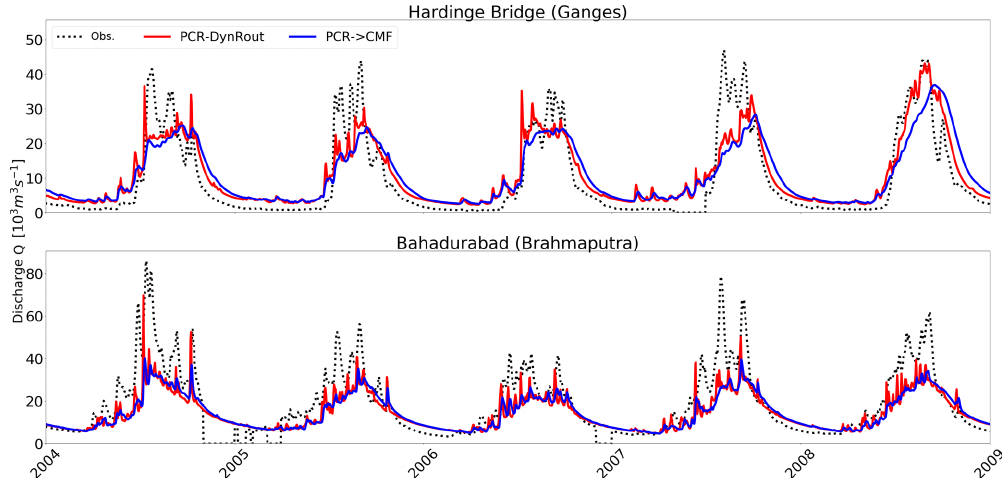
Figure 5. Simulated discharge by PCR-DynRout and PCR → CMF as well as observed discharge at both Hardinge Bridge (Ganges) and Bahadurabad (Brahmaputra).